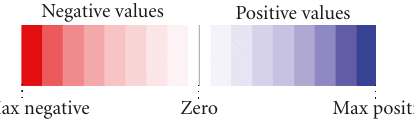
Figure 3: Color scheme for presenting information on both the intensity and orientation of the velocity: orientations with negative values are red, and orientations with positive values are blue. The faster a movement is, the stronger the color that represents it will